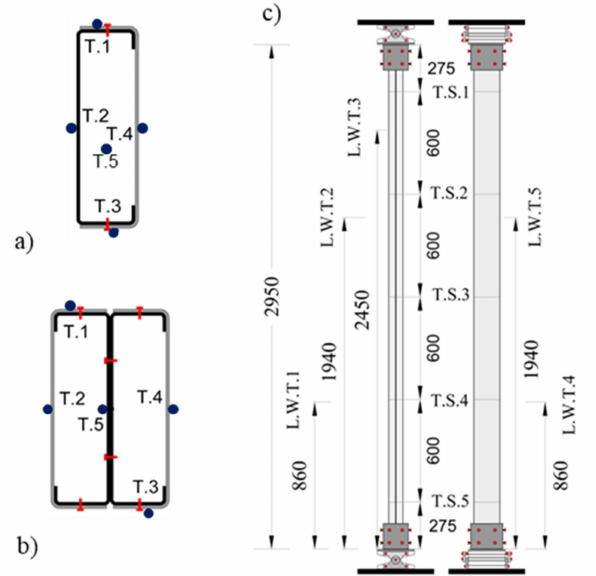
Figure 4. Instrumentation used and corresponding location (all dimensions in mm). ( a , b ) Position of thermocouples. ( c ) Position of thermocouples and transducers along the length of the